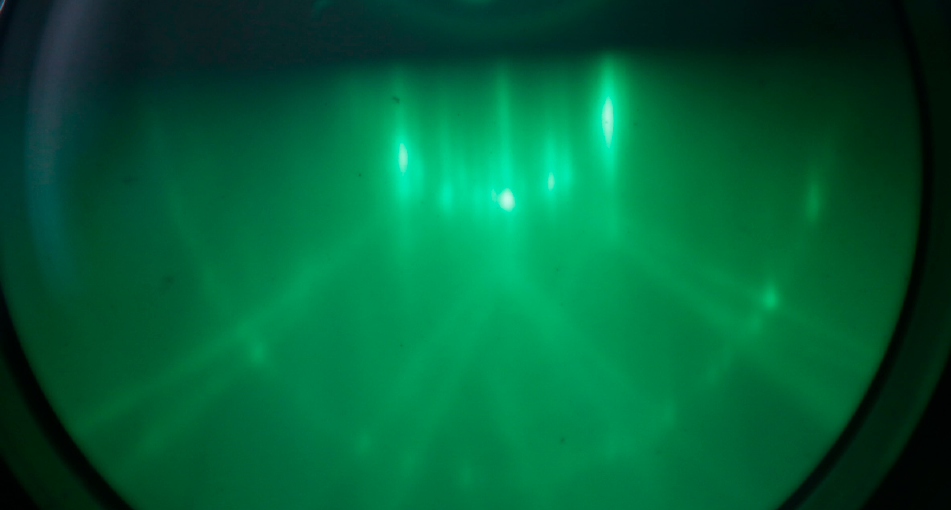
Figure 5. RHEED image of the Si substrate surface after removing a protective oxide and the Si buffer layer growth.